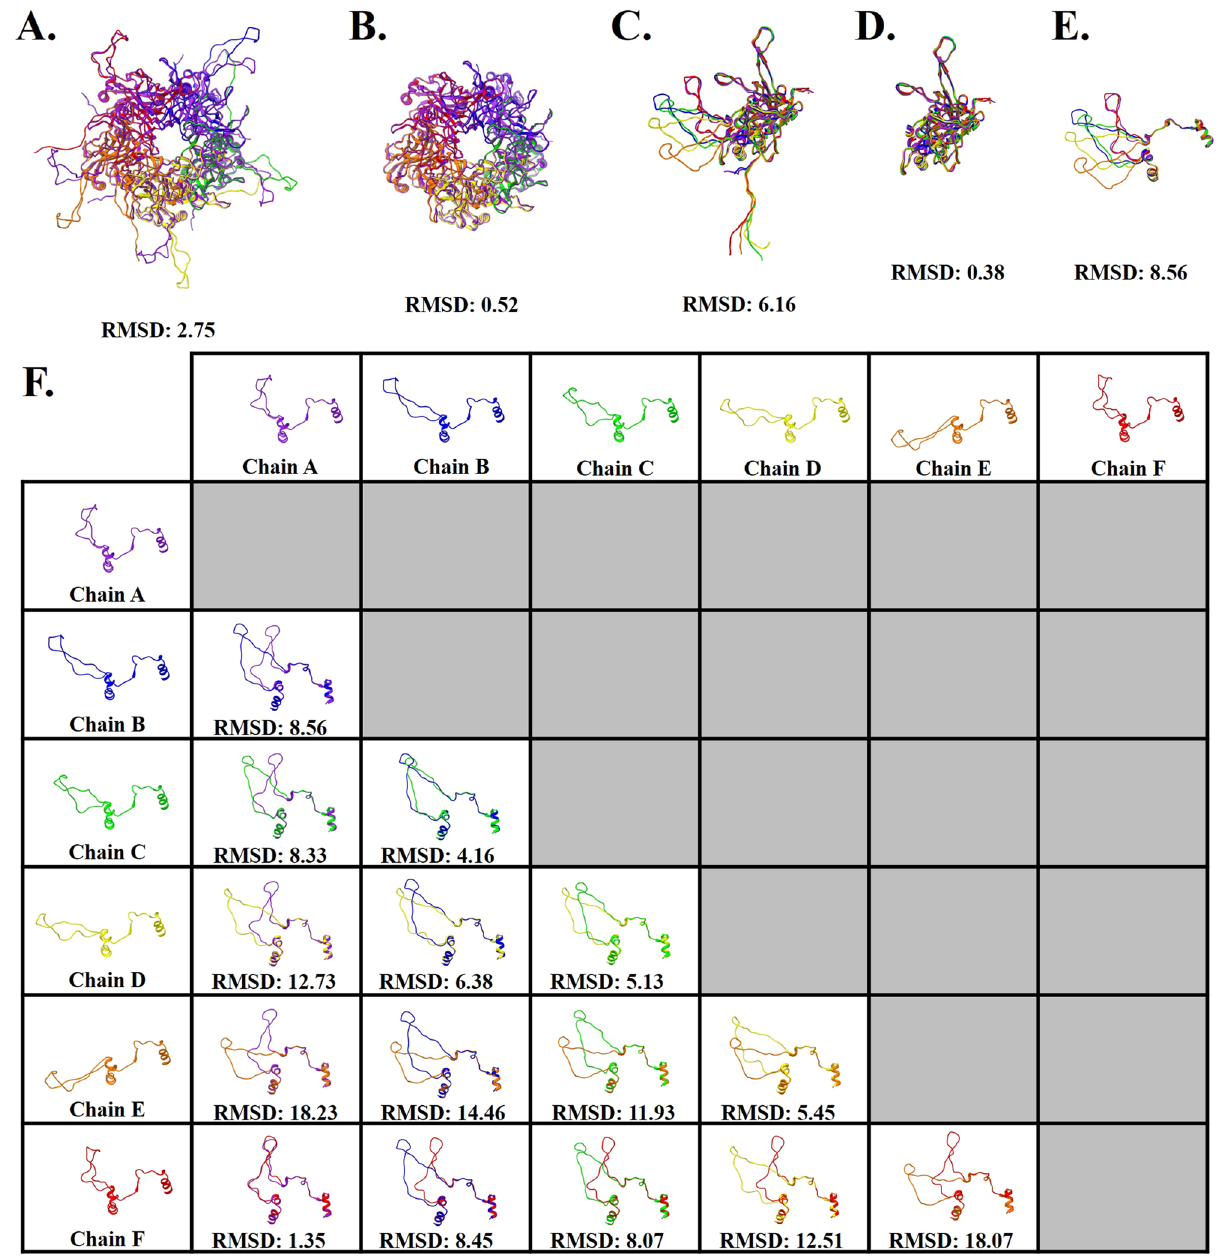
Figure 3. Differences in L1 structural conformation. All RMSD values are given in Angstroms. ( A ) Pentavalent (five A chains, purple) and hexavalent (chain B–F, blue, green, yellow, orange, and red) capsomers superimposed with an RMSD of 2.75 Å. ( B ) Structure comparison of pentavalent and hexavalent capsomer conformations excluding amino acid side chains 402–439 that extend as a connecting arm to the neighboring capsomer, and the N-terminal residues 1–23. ( C ) Structure comparison of the six L1 conformations, making up the asymmetric unit chains A–F. ( D ) Structure comparison of the six L1 conformations, excluding amino acid side chains from the connecting arms and the N-terminal residues. ( E ) Structure comparison of the connecting arms of the six different L1 conformations found in the asymmetric unit. The flanking secondary structure was included for alignment, depicted as amino acid residues 385–472. ( F ) Pair-wise structure comparison of the six connecting arm conformations and their associated RMSD